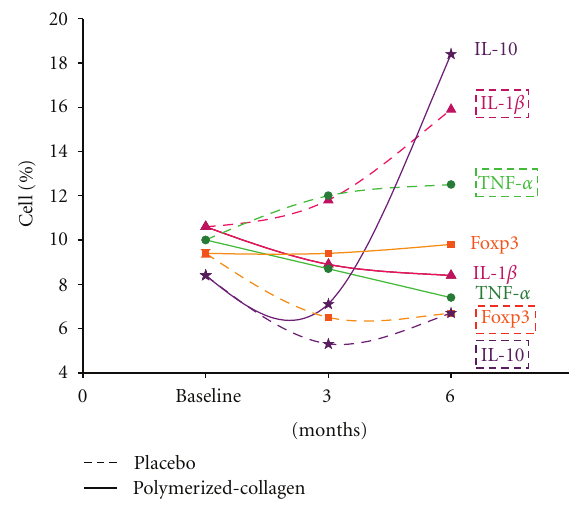
Figure 3: Total cytokine- and Foxp3-expressing peripheral cells in patients with symptomatic knee OA under Polymerized-type I collagen or placebo at baseline, 3, and 6